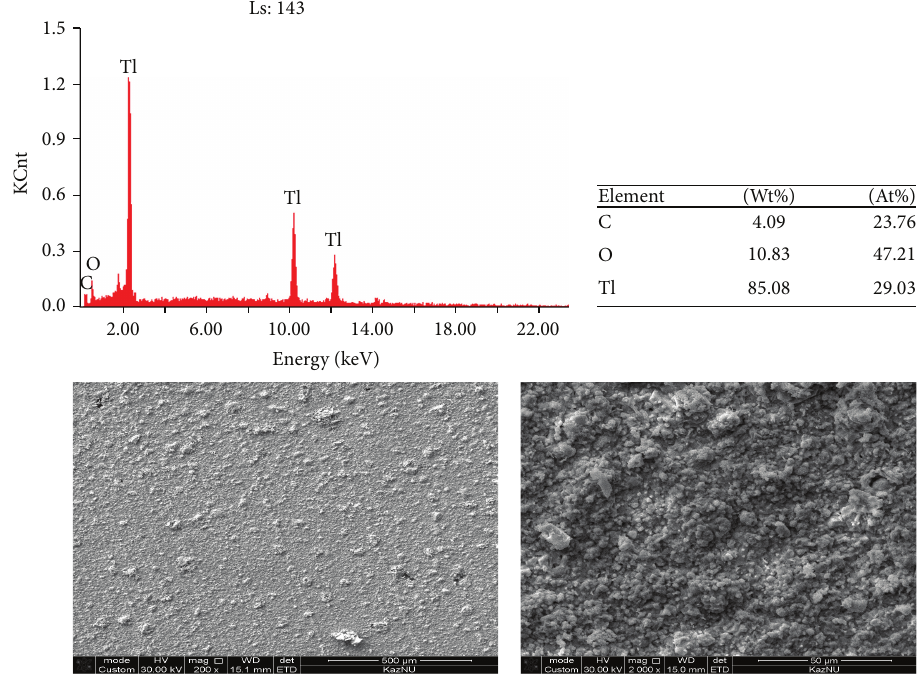
Figure 14: The results of the analysis of the surface of glassy carbon electrode obtained after deposition of thallium at 𝐸 = − 800mV in 0.01 mol/L solution of Tl 2 SO 4 ; background is Na 2 SO 4 , pH = 7 without stirring.